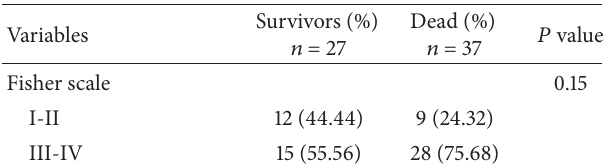
Table 1: Univariate analysis of characteristics of rebleeding patients after aneurysmal